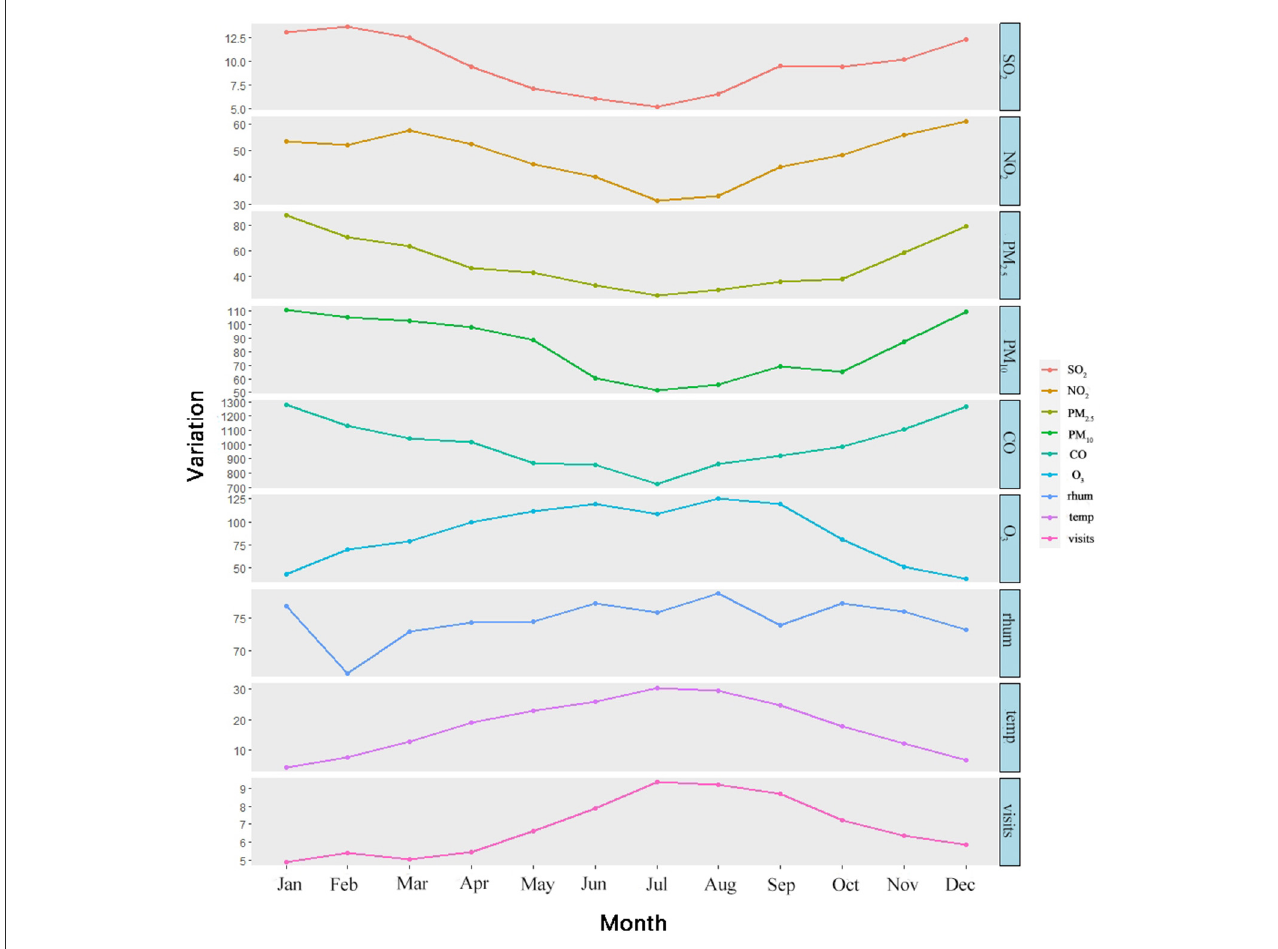
FIGURE2 The monthly average variation of pollutants, temperature, relative humidity, and daily emergency department visits for urolithiasis.